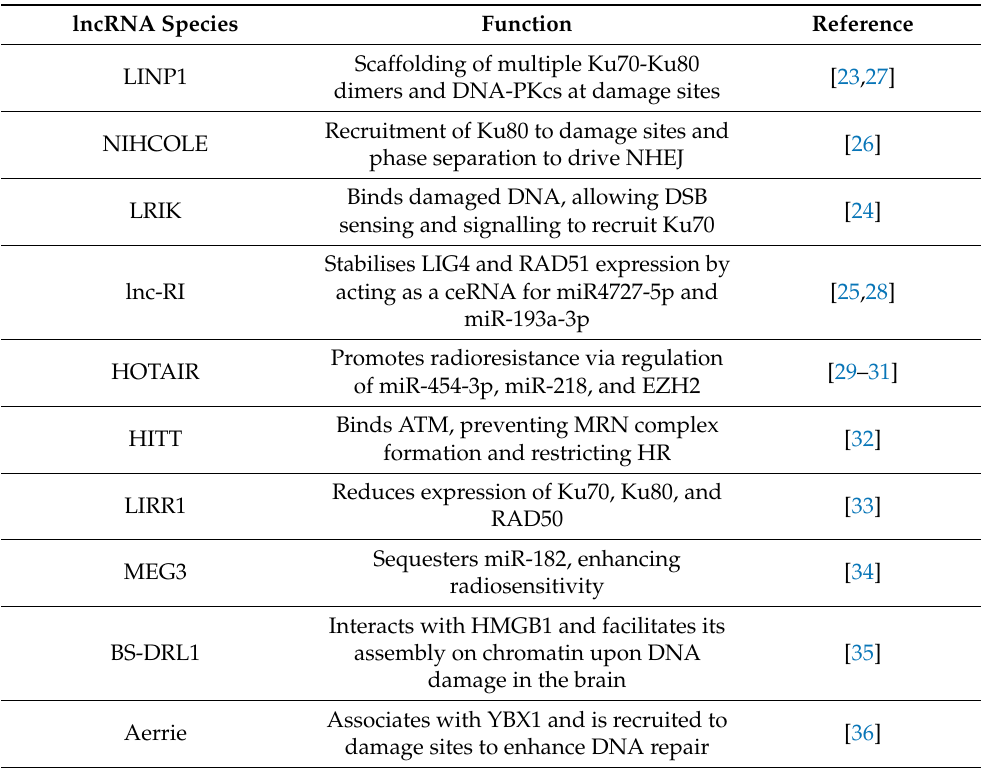
Table 1. lncRNA species and their roles in